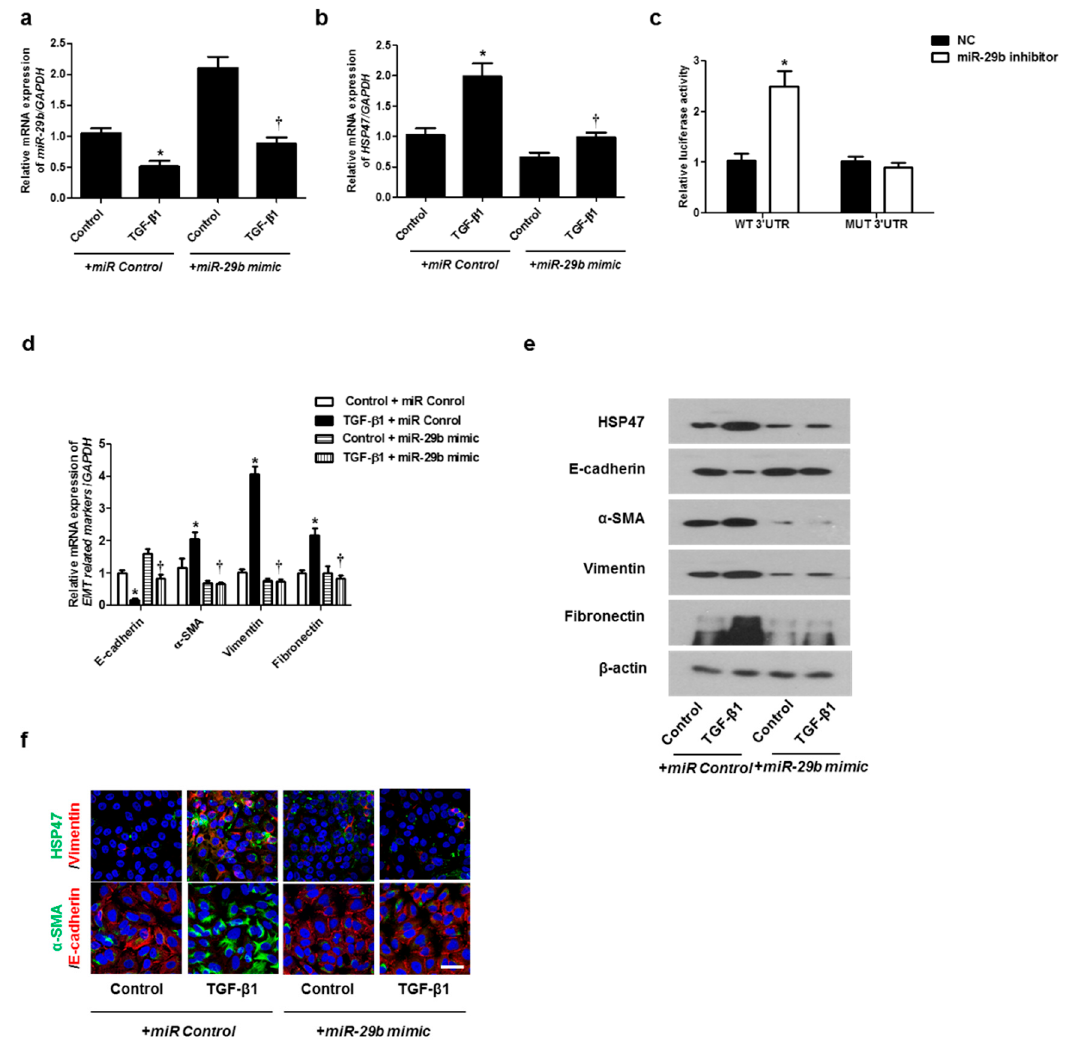
Figure 2. Overexpression of miR-29b inhibited mRNA and protein expression levels of TGF- β 1-induced EMT markers in A549 cells. A549 cells were stimulated with TGF- β 1 (5 ng/mL) with miR control or miR-29b mimic . ( a , b ) mRNA expression levels of miR-29b and HSP47 were determined using qPCR. ( c ) HSP47 luciferase activity was measured by luciferase assay. ( d ) E-cadherin, α -SMA, vimentin, and fibronectin mRNA levels were analyzed through qPCR. ( e ) Protein expression levels of HSP47, E-cadherin, α -SMA, vimentin, and fibronectin were determined using Western blotting. ( f ) The cells were treated with TGF- β 1 for 72 h after transfection of miR-29b mimic and then assessed for HSP47 (1st line, green), vimentin (1st line, red), α -SMA (2nd, green), and E-cadherin (2nd, red) expression/localization using immunofluorescence. Nuclei were stained with DAPI (blue). Scale bar = 20 μ m. Values are expressed as mean ± SEM of three independent samples. * p < 0.05, vs. control + miR Control ; † p < 0.05, vs. TGF- β 1 + miR Control .